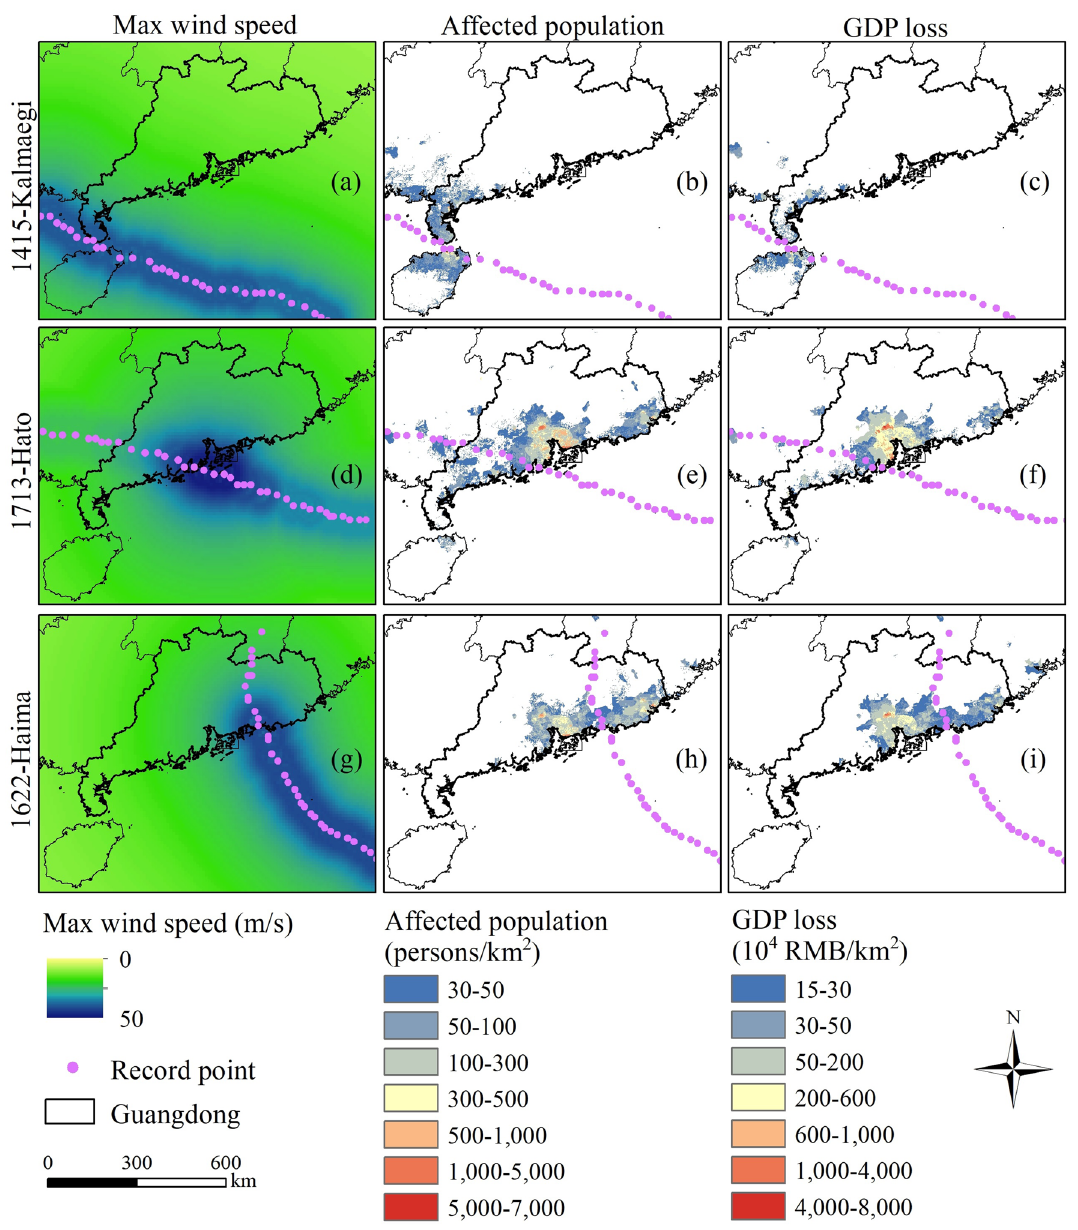
Fig. 6 Spatiotemporal distribution of maximum wind speed (MWS), affected population, and direct GDP loss simulated for tropical cyclones Kalmaegi (1415), Hato (1713), and Haima (1622)